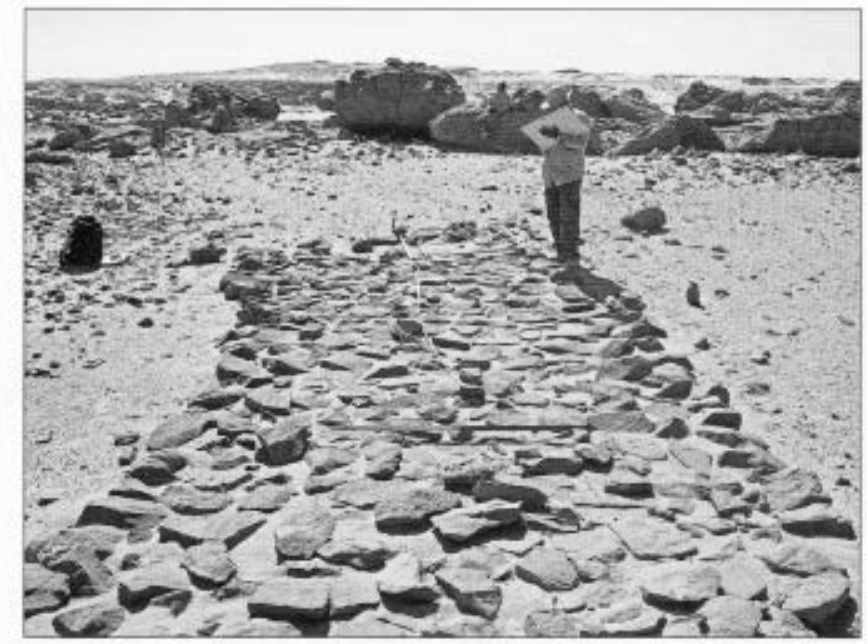
Figure 8 New Kingdom paved road at Gebel Gulab,